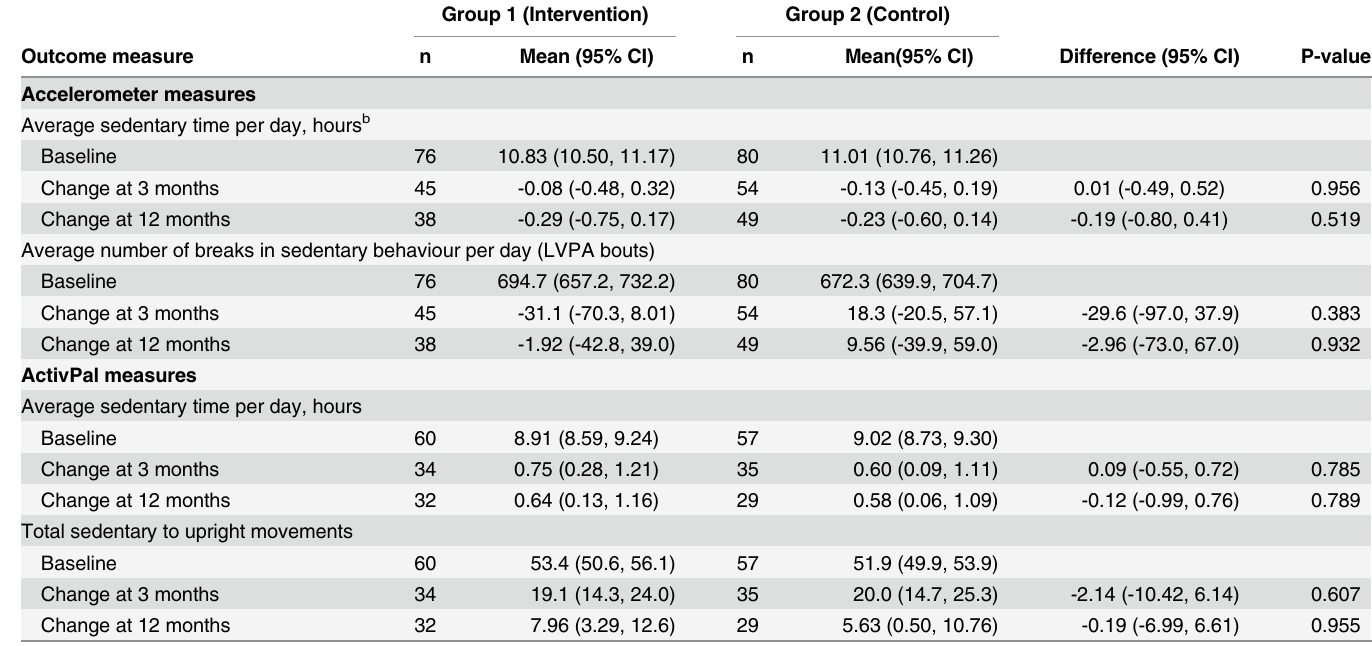
Table 2. Sedentary outcomes by randomisation group (intention to treat analysis) a